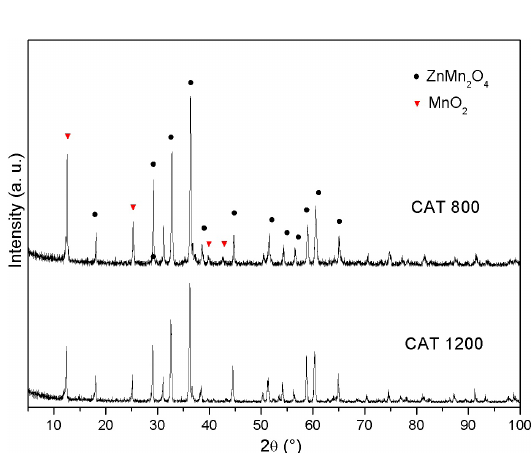
Figure 1. X-ray diffractogram of the of the CAT 800 and CAT 1200 samples after heat treatment at 800 °C and 1200 °C, respectively.